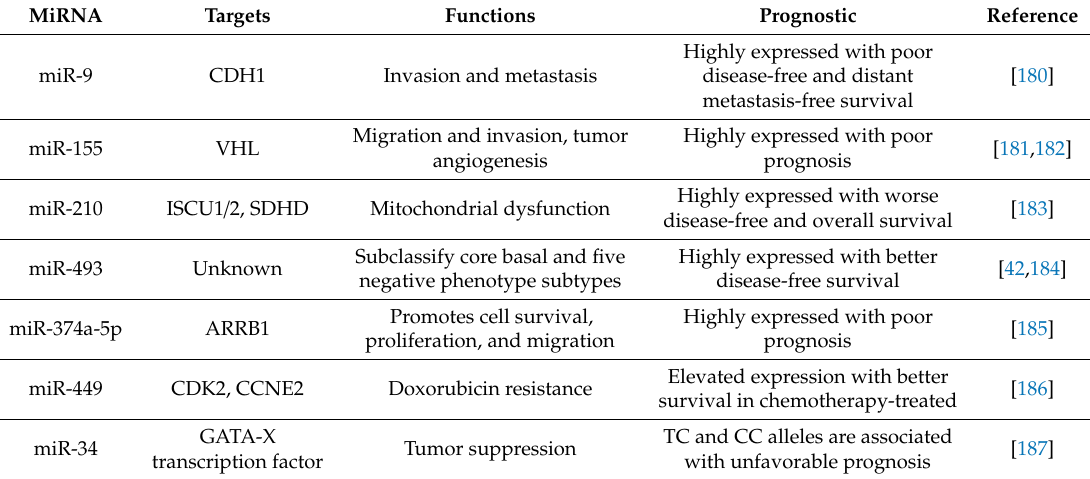
Table 8. MiRNAs associated with prognosis in